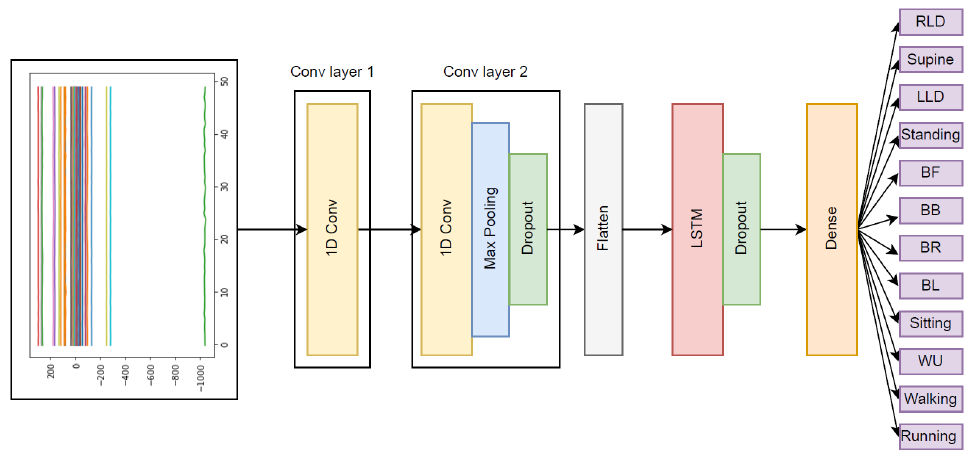
Figure 7. In addition to LSTM and CNN, we developed a hybrid model for activity classification.